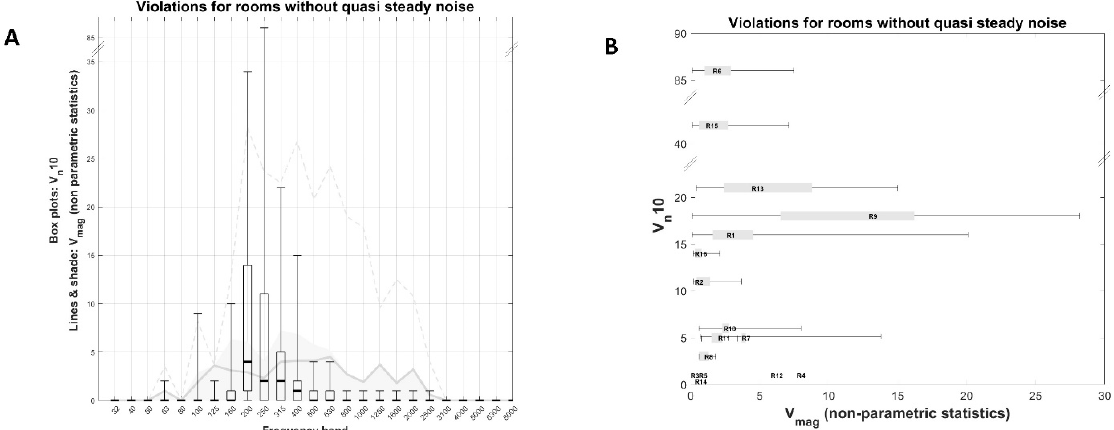
Figure 3. ( A ) Descriptive statistics of V n 10 in boxplots and V mag in lines and shaded areas for all rooms without quasi-constant violations combined (rooms 1 to 16). Solid grey line: median, shaded area: 1st to 3rd quartile, dashed line: max. ( B ) V mag non-parametric descriptive statistics vs. V n 10 of each room’s most frequently violated frequency band. No violations were recorded in Room 14. V n 10 is the number of data points (1 sample per second) that violate Maximum Permissible Ambient noise levels. V mag is the magnitude of the violation in